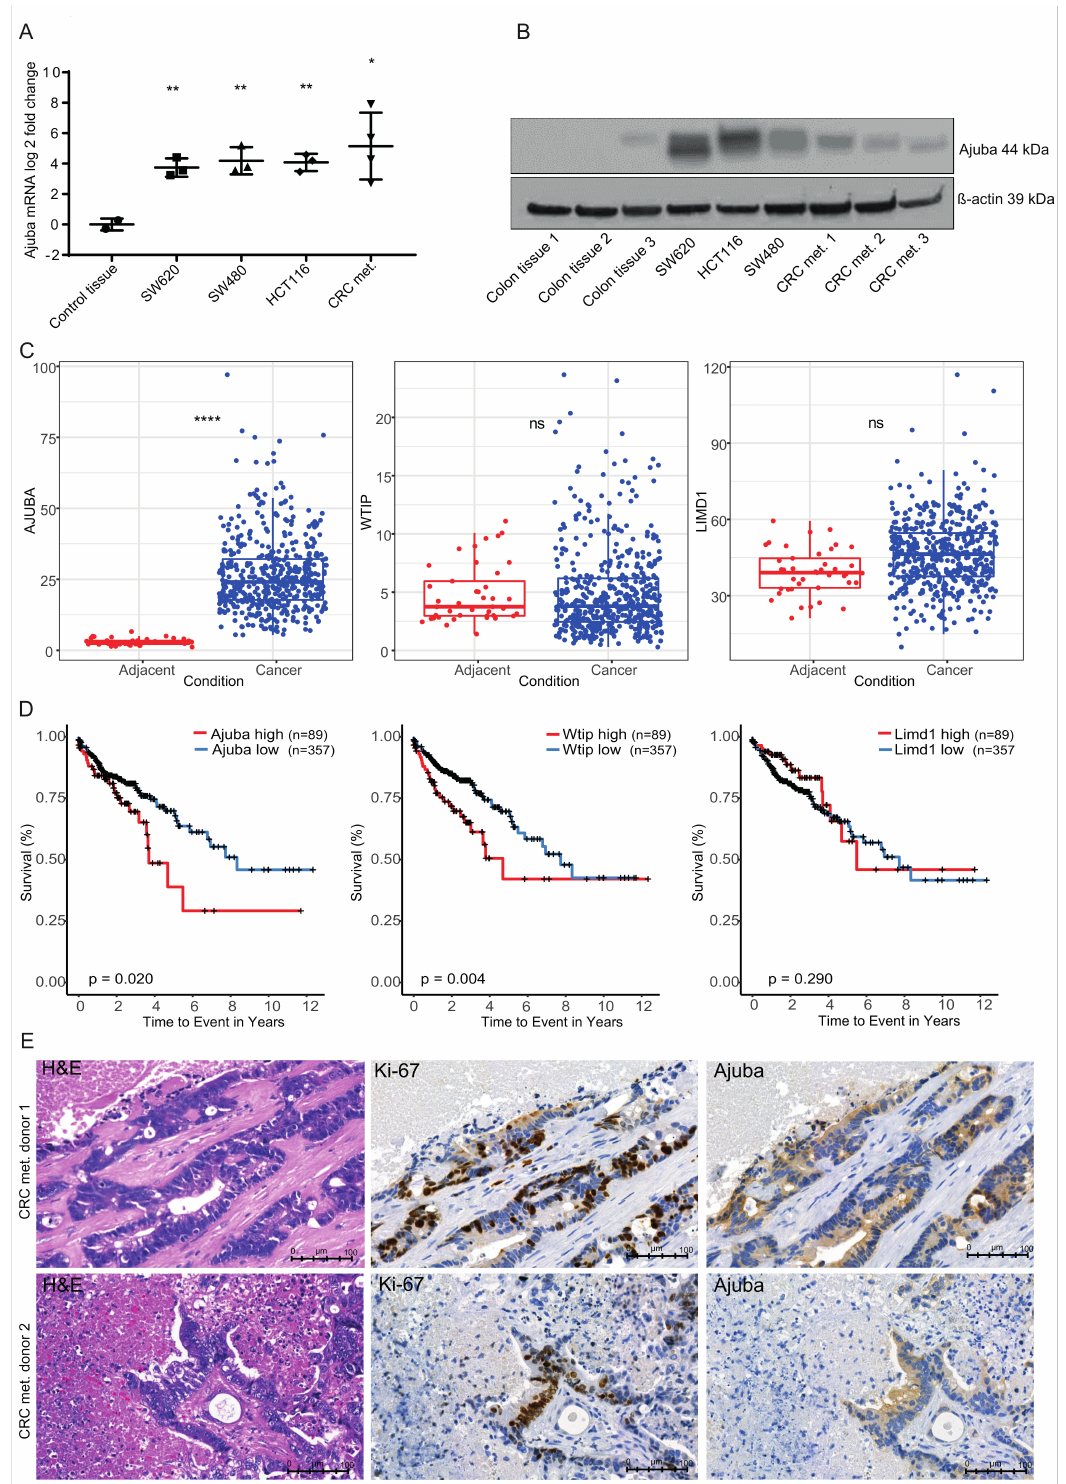
Figure 1. Ajuba expression is increased in human colon cancer cell lines and metastatic tumor tissue. ( A ) Ajuba mRNA expression level measured by RT-qPCR in colon cancer cell lines and human tissue of CRC metastasis in the liver normalized to human control Intestine. Control tissue vs. SW620 = 0.0048, Control tissue vs. SW480 = 0.0093, Control tissue vs. HCT116 = 0.0033, Control vs. CRC metastasis 0.0360. ( B ) Western blot analysis of Ajuba protein in human primary colon, colon cancer cell lines and human tissue of CRC metastasis in liver. ( C ) Ajuba, WTIP and LIMD1 normalized mRNA